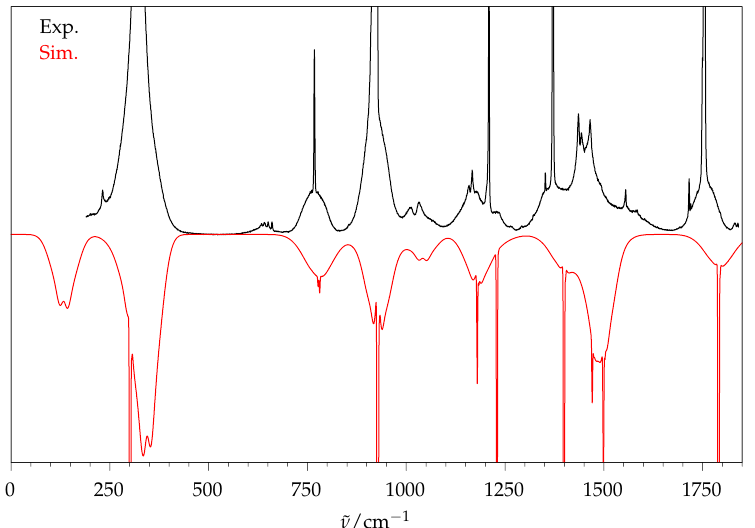
Figure 6. Experimental gas phase spectrum of methyl methanoate (top black trace) and rovibrational simulation for 298K and σ = 1.0cm − 1 (bottom red trace).